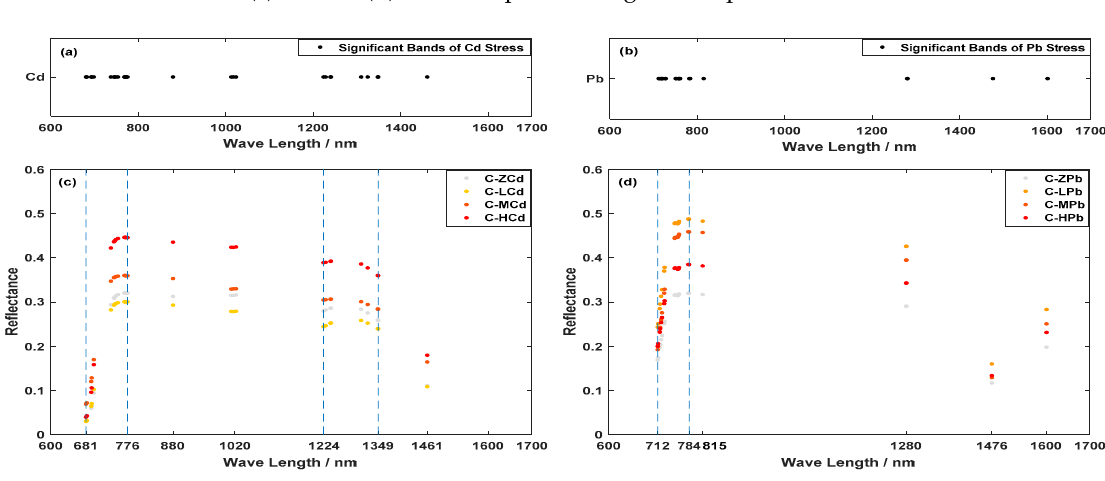
8 of 17 Figure. 3 Numbers of significant bands selected with different pre-processing methods The number of significant bands selected for Pb stress was no more than 10 in any pretreatment with the most bands of nine, while the most pre-processing methods for Cd stress were less than 10 with the most bands of 13. The minimum number of significant bands for Cd and Pb were 3 and 4,